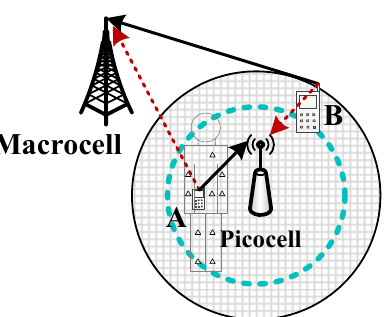
Figure 2. System model. Each picocell holds a circular boundary ( i.e. , the azure dashed circle) indicating the PSNE. Device A is inside the boundary, so it transmits to the picocell and interferes with the macrocell. Although Device B is within the edge of the picocell, it is outside of the dashed circle, so it selects the macrocell and interferes with the